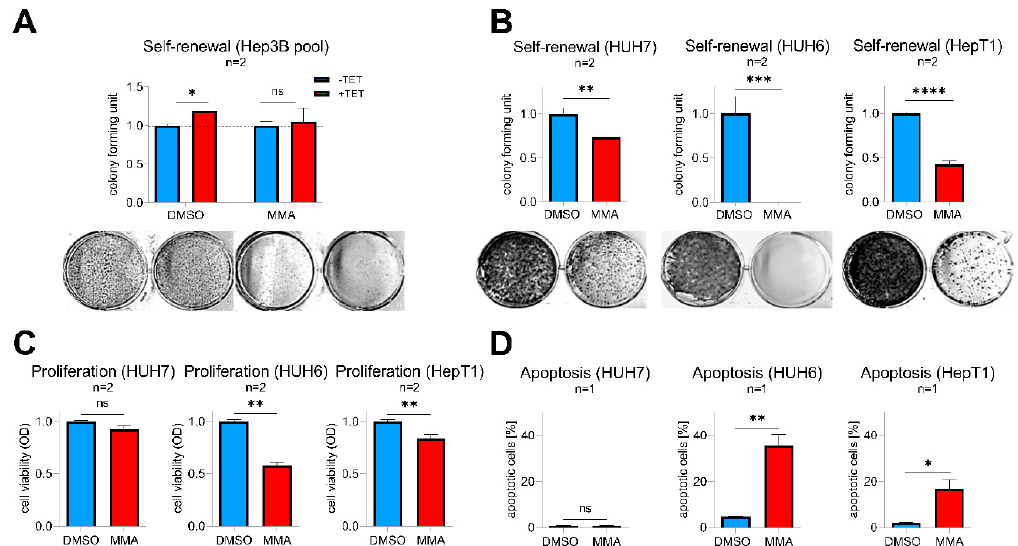
Figure 6. ( A ) Hep3B pool cells were treated with 10 nM mithramycin A (MMA) or DMSO as a control with (+TET) or without ( − TET) SP8 ‐ induction. ( B – D ) HUH7, HUH6, and HepT1 cells were treated with 10 nM (HUH7 and HUH6) or 30 nM (HepT1) MMA or DMSO as a control. ( A , B ) Self ‐